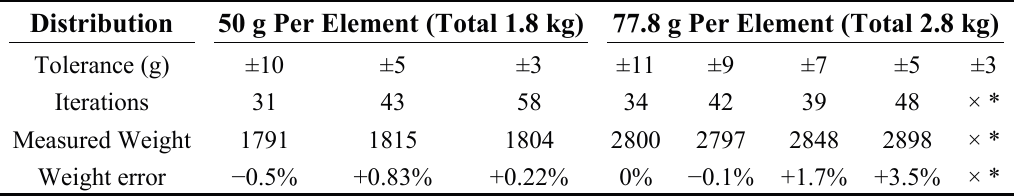
Table 3. Results of automatic force distribution test with even distribution.